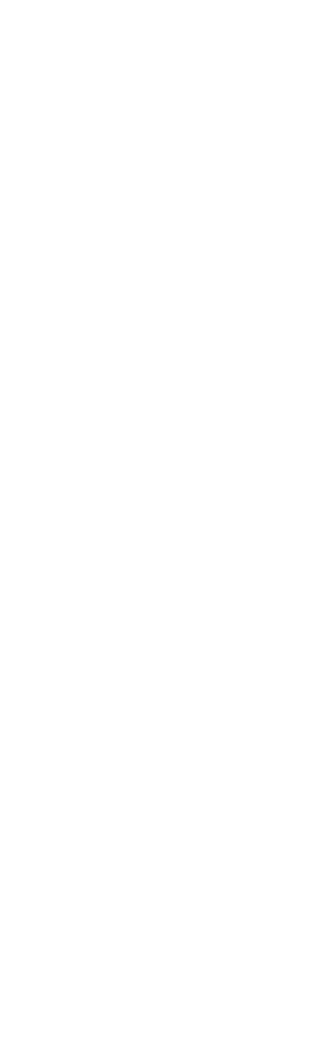
FIGURE 1 | Timeline of the case after admission. (A – C) Time course of CK, myoglobin, plasma creatinine, and levels of uPCR and uACR. (D) Time of treatment regimens and kidney biopsy. CK, creatinine kinase; CYC, cyclophosphamide; uACR, urinary albumin-to-creatinine ratio; uPCR, urinary protein-to-creatinine